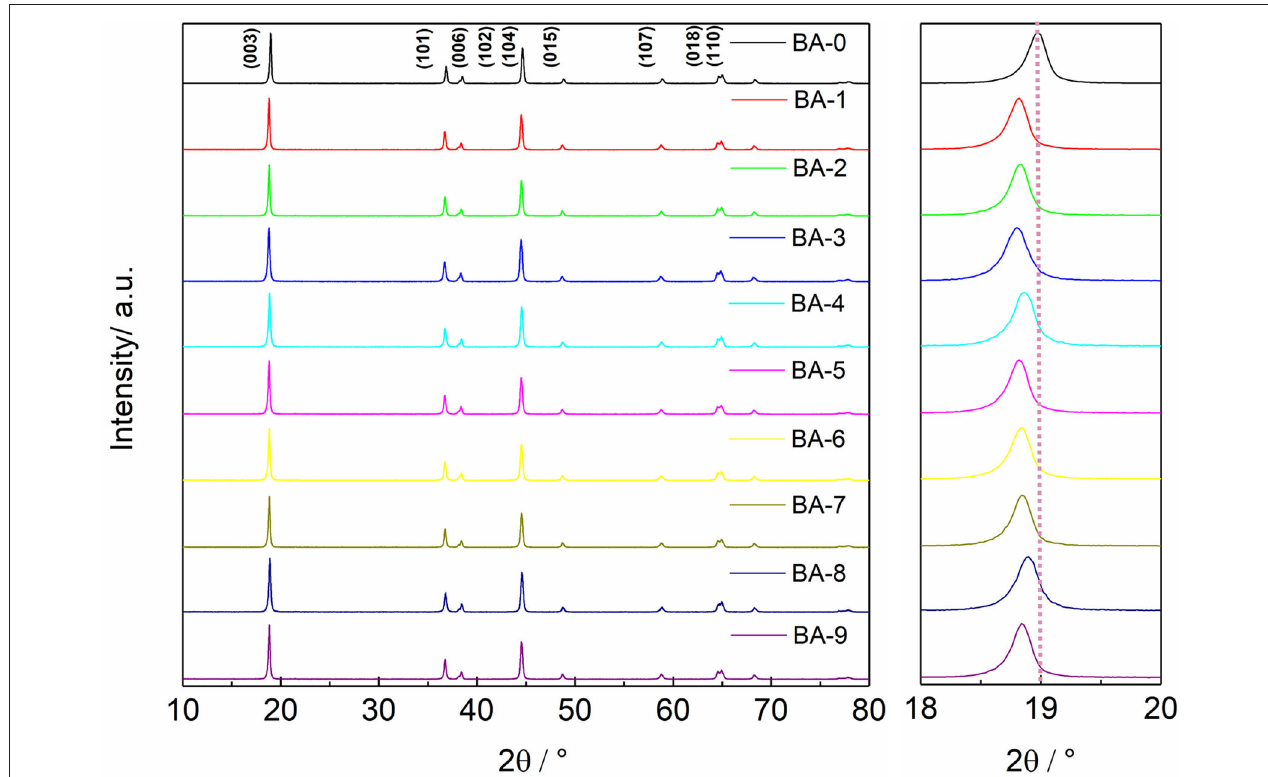
FIGURE 3 | The whole and detailed XRD patterns of all samples.